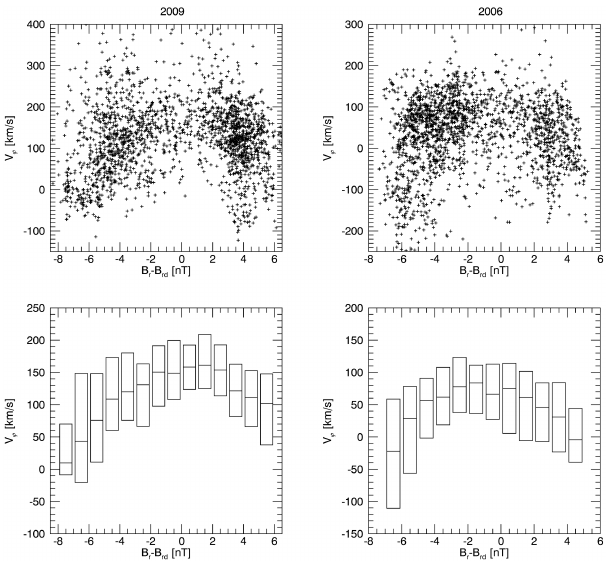
Figure 4. Residual magnetic field – azimuthal velocity scatter plots (upper panels) and box-plots (lower panels) for proton data mea- sured in the nightside outer magnetosphere of Saturn. Left panels: 2009, right: 2006. The three horizontal lines of each box represent the first, second and third quartiles of the corresponding bin. The velocity approaches zero far away from the magnetic equator, while the central sheet of the magnetodisk rotates rapidly. (Its speed is approximately 160kms − 1 for 2009 and 90kms − 1 for